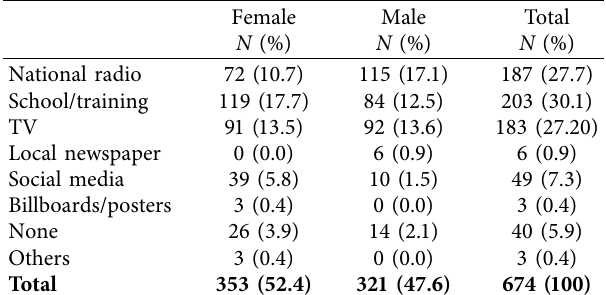
Table 10: Preferred method of receiving climate information.